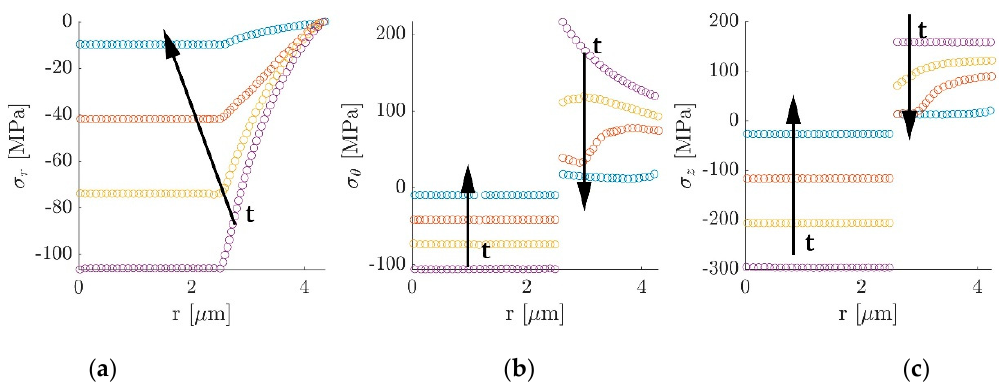
Figure 27. Stress distribution during discharging: ( a ) radial stress; ( b ) hoop stress; ( c ) axial stress from Xu et al. [100].